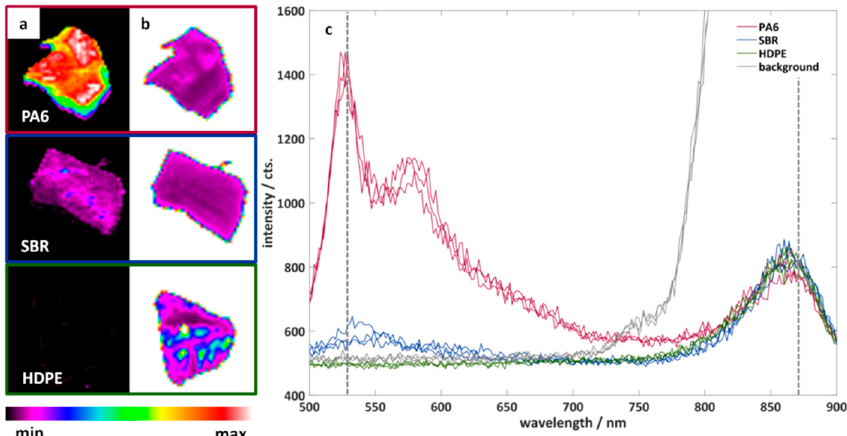
Figure 4. Color-coded fluorescence intensity of three particles of black plastics measured with the imaging fluorescence spectrometer at a wavelength of ( a ) 530 nm and ( b ) 870 nm. ( c ) Example spectra of the three plastic particles. Red: polyamide 6 (PA6). Blue: styrene-butadiene rubber (SBR). Green: high-density polyethylene (HDPE). Grey: background.